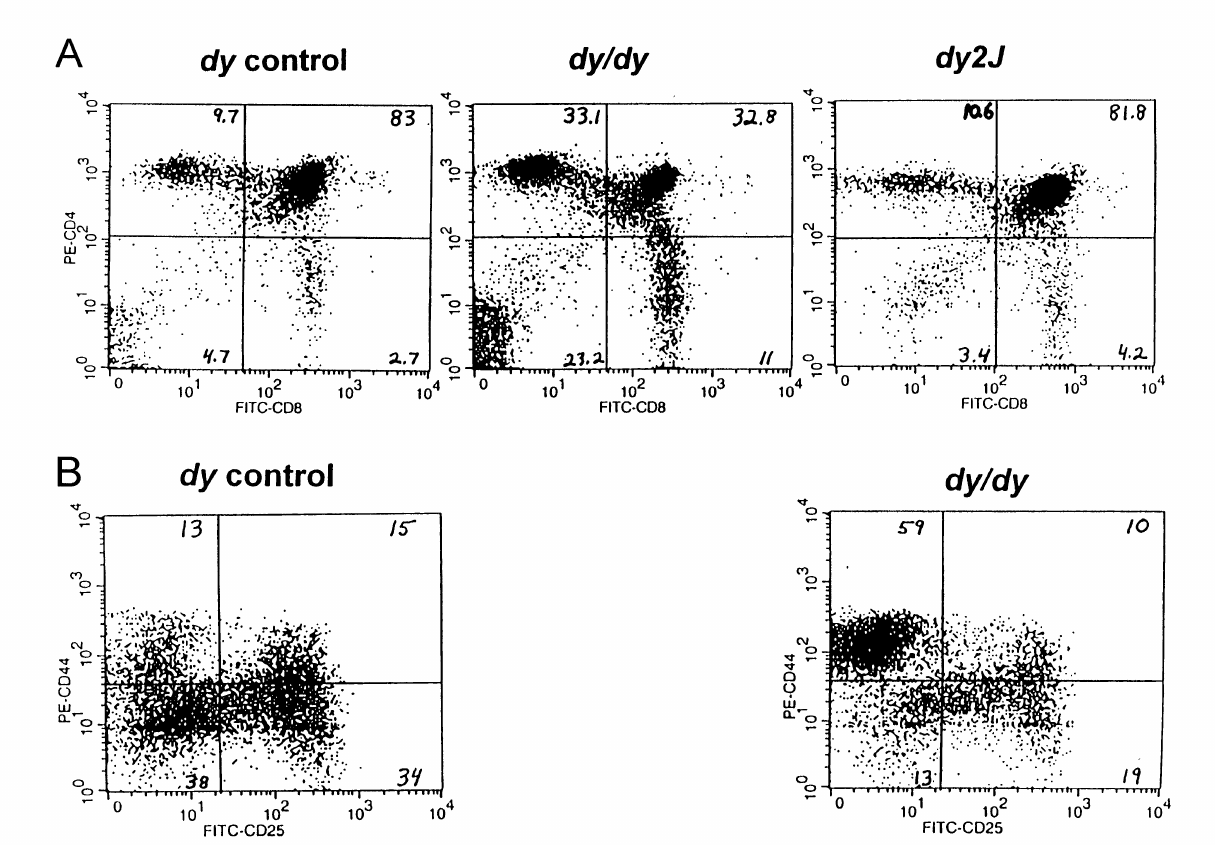
FIGURE 2 Flow cytometric analyses of dystrophic and control thymocytes. To characterize thymocyte populations, thymocytes isolated from dystrophic and control mice were stained with antibodies to thymic subset markers and analyzed by flow cytometry. The quadrant per- centages are shown within each quadrant. These plots clearly show significant loss of cells from the CD4+CD8+and CD4-CD8-CD44-CD25 populations in the dy/dy mice. A. Bulk thymocytes from dy/dy and dy control and dy 2J mice were stained with PE-anti-CD4 and FITC-anti-CD8. Maturation progresses from CD4- CD8- to CD4+CD8 to CD4+CD8 or CD4-CD8 B. DN thymocytes were prepared from dy/dy and dy control animals and stained with PE-anti-CD44 and FITC-anti-CD25. Maturation progresses from CD44+CD25 to CD44+CD25 to CD44-CD25 to